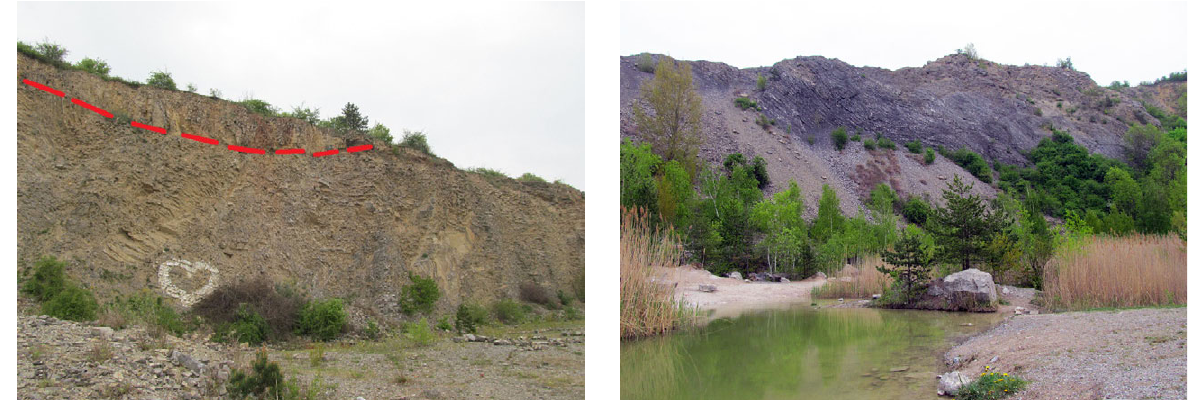
Fig. 3. (a) The transgression of the jura limestones on the folded Devonian limestones in the upper bench of the Hády quarry, (b) The bottom of the Hády quarry (Růženin lom) flooded with a lake; in the background, the alternation of limestone, clay limestone and calcic claystone can be observed (Photo: L. Kubalíková, 2015).